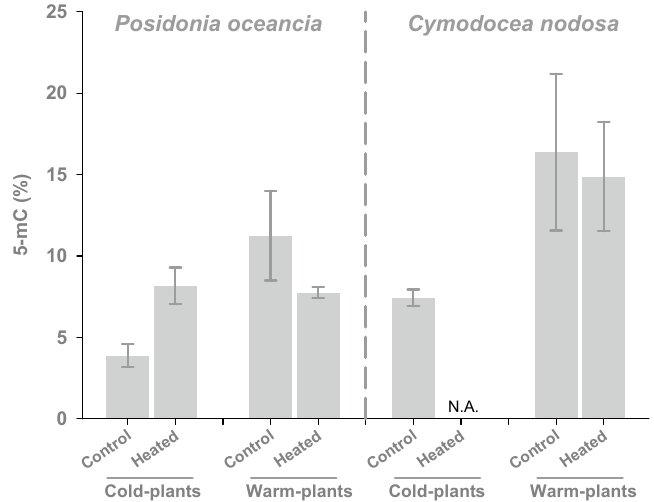
Figure 6. Global genomic methylation levels in P. oceanica and C. nodosa cold- and warm-adapted ecotypes from the control and heated treatments at the end of the warming exposure. Methylation values were calculated as percentage of the methylated-C in total genomic